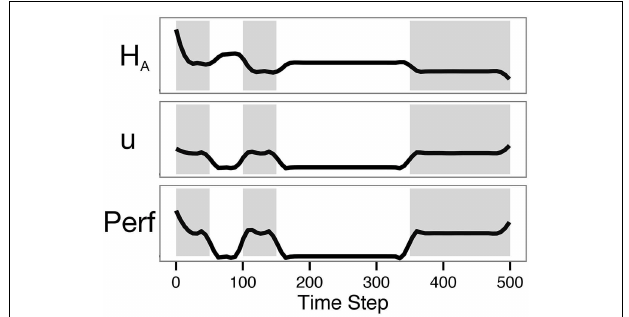
FIGURE 7 | The model predicts lower performance on the second task of a dual-task paradigm. The plot shows results from Simulation 2, with zero intrinsic cost and a lookahead of 500. Shading indicates periods in which the agent could be rewarded (on-task periods). Note that overall performance in the second shaded period is lower than performance in the